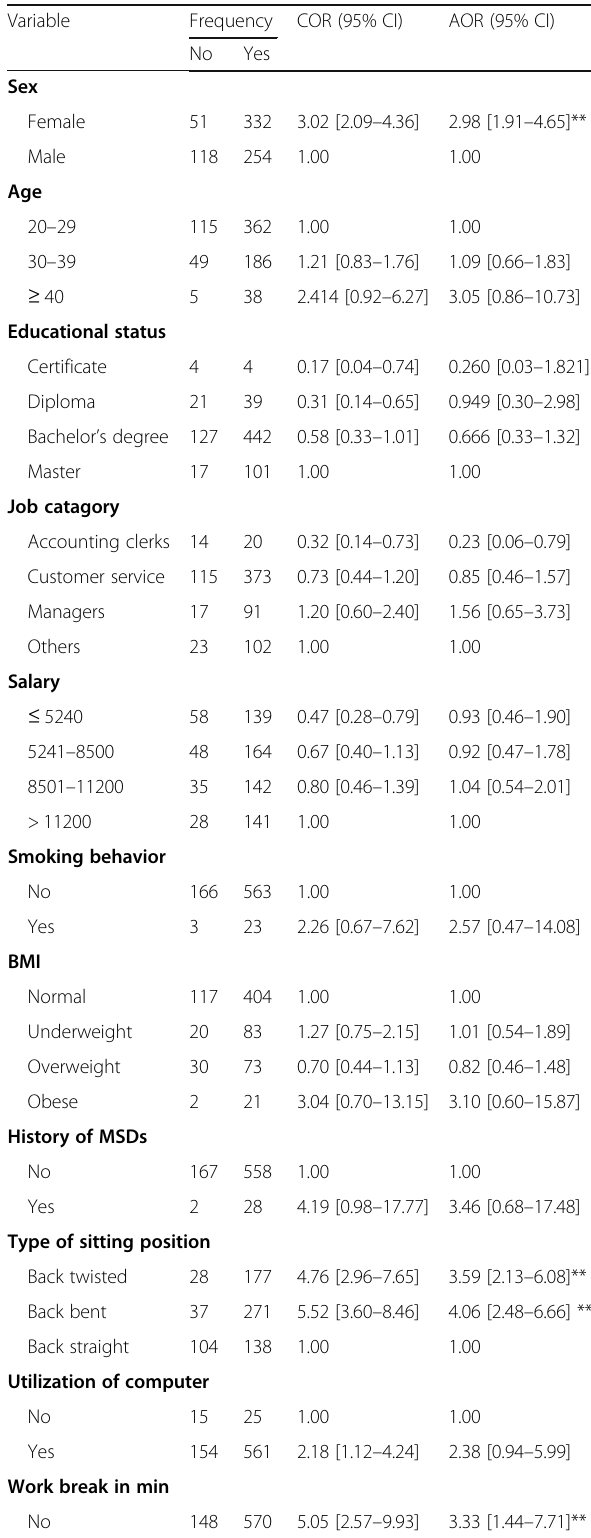
Table 4 Multi variable analysis of factors associated with work- related musculoskeletal disorders among bank workers, Addis Ababa, Ethiopia, 2018 ( N = 755)